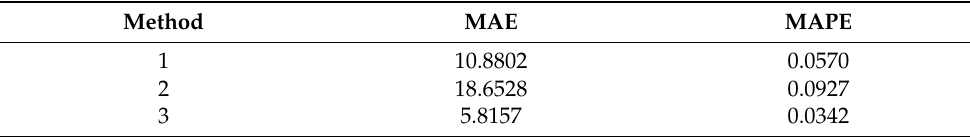
Table 8. MAE and MAPE error values for individual methods.